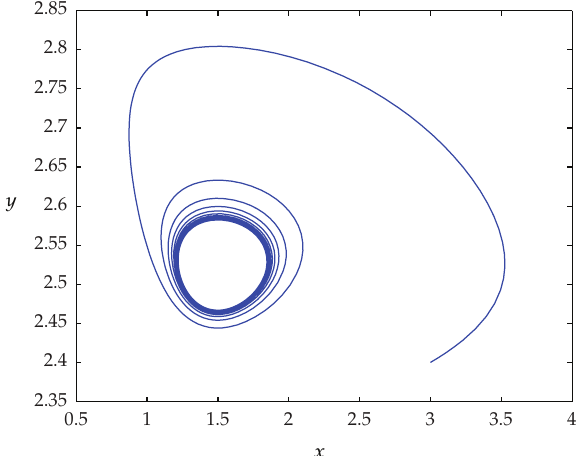
Figure 1: The bifurcated periodic solution is